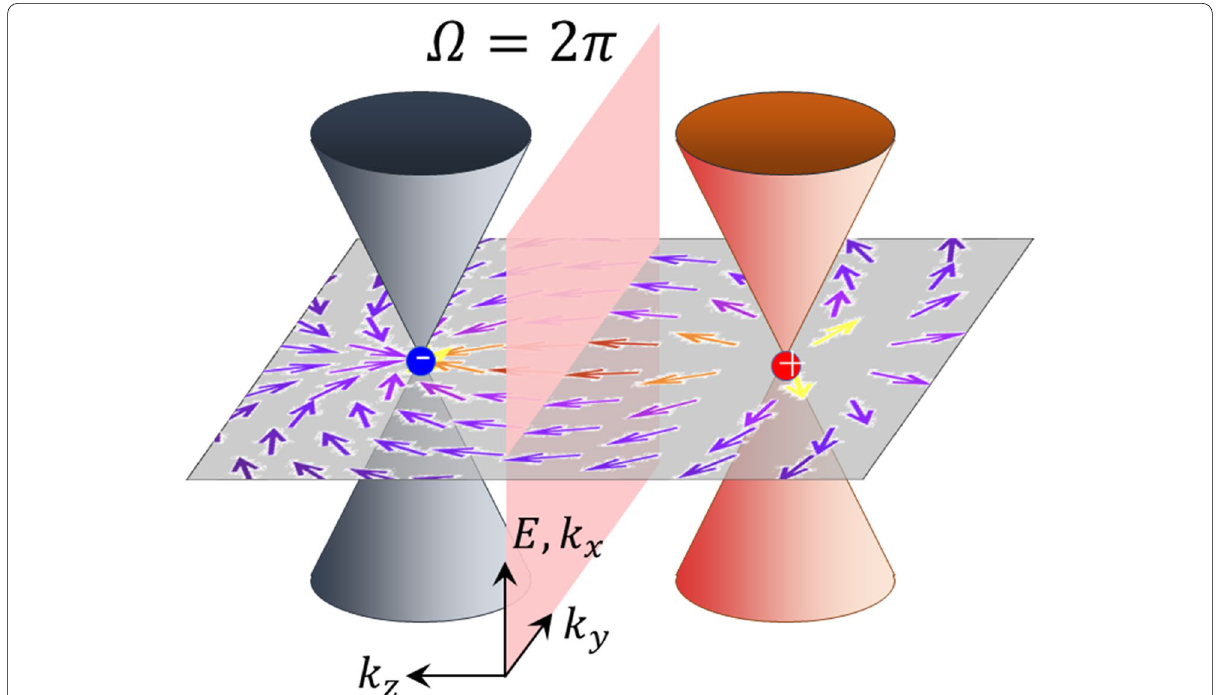
Fig. 3 Conceptual schematics of a Weyl semimetal [4]. Pairs of Weyl points with positive and negative magnetic monopoles (magnetic charges) exist in a Weyl semimetal, which act as the north and south poles of the fictitious magnetic field. When only a single pair of Weyl points exists at the Fermi energy, any surface perpendicular to the line connecting them corresponds to a two-dimensional semiconducting system. The flux of the fictitious magnetic field through this two-dimensional semiconducting plane is quantized to 2π based on Gauss’s law. This implies that this plane is a precise quantum Hall system, which displays a giant Hall effect when time-reversal symmetry is broken. Essentially, a Weyl semimetal can be considered a layered quantum Hall system. This is the origin of the giant anomalous Hall effect in a Weyl magnet (reproduced from reference